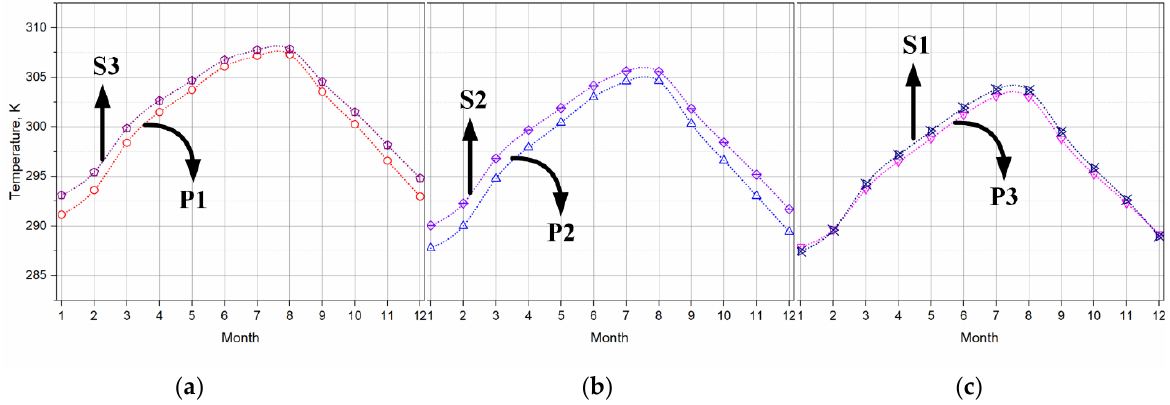
Figure 5. Water outlet temperature comparisons ( a ) S3-P1 ( b ) S2-P2 ( c ) S1-P3.